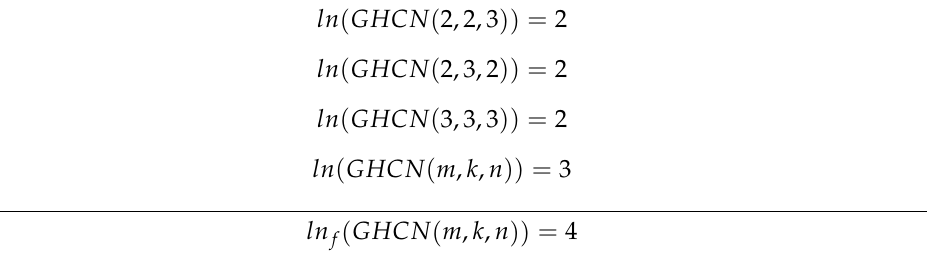
Table 8. Locating numbers of GHCN ( m , k , n ) .